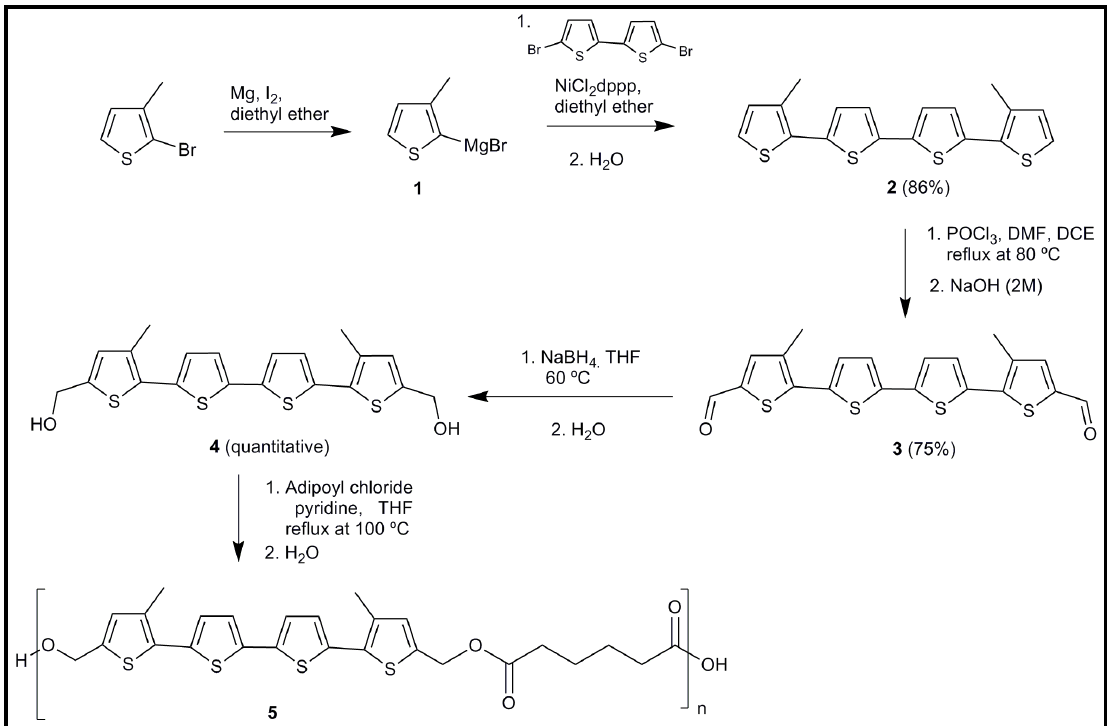
Figure 24. Synthesis of poly(5,5 ′′′ -bis(hydroxymethyl)-3,3 ′′′ -dimethyl-2,2 ′ ,5 ′ ,2 ′′ ,5 ′′ ,2 ′′′ - quaterthiophene- co -Adipic Acid)